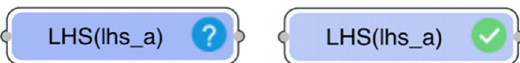
Figure 8 The identifier changes from the question mark to green tick when a block is implemented successfully